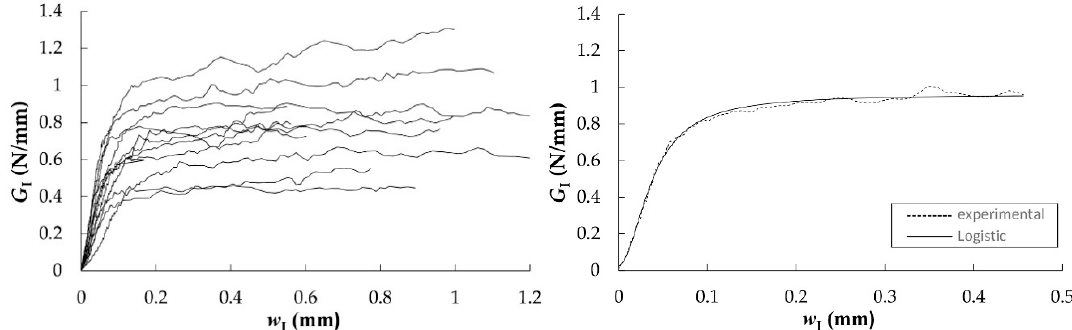
Figure 9. Characteristic G I - w I curves in TL (left); experimental G I - w I curve of “140-1-TL” specimen and least-square regression with the logistic function (right).